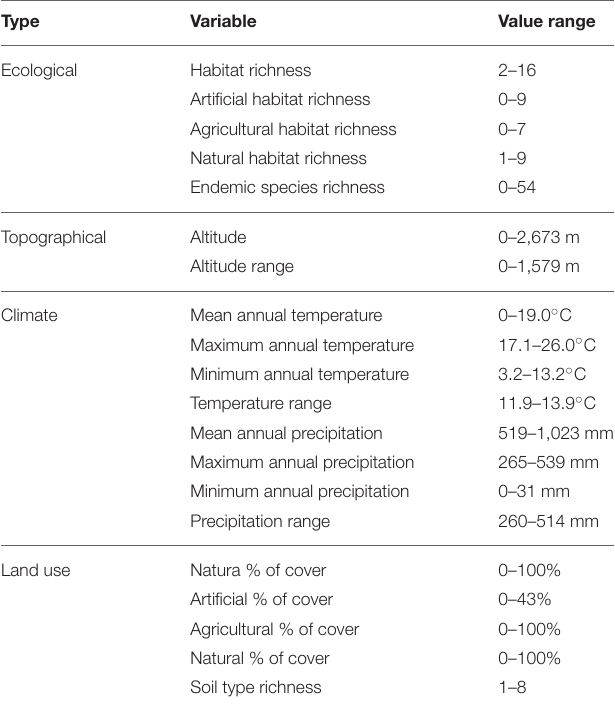
TABLE 1 | Environmental variables used as input for the estimation of alien species